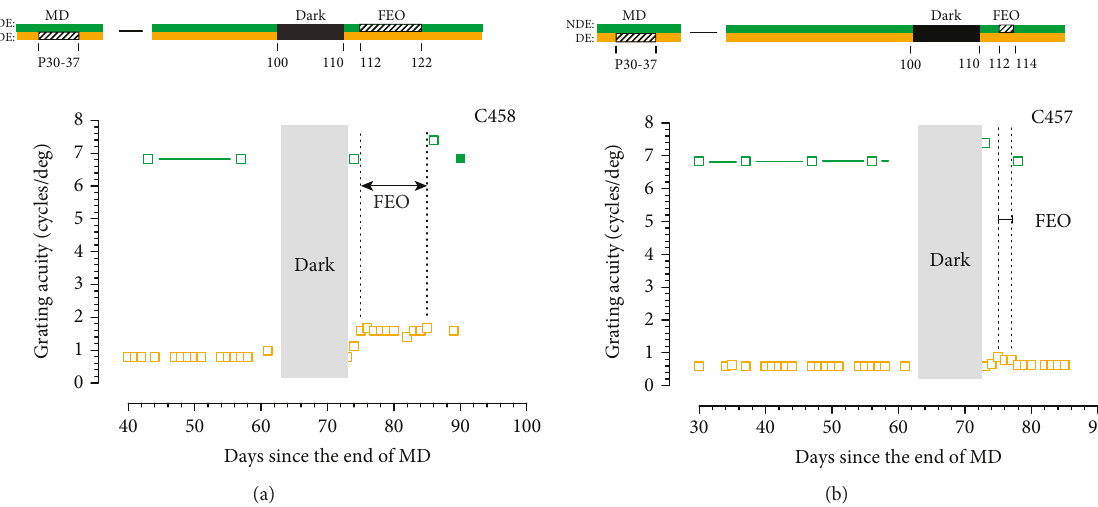
Figure 9: The grating acuity of the deprived eye (orange symbols) and the binocular or nondeprived eye acuity (green symbols) of two monocularly deprived kittens C458 (a) and C457 (b) surrounding 10 days of total darkness followed immediately by a 2-day period of binocular visual exposure that preceded fellow eye occlusion (FEO) for either 10 or 2 days. The period of FEO e ff ectively blocked any further improvement of the acuity of the deprived eye that began during the brief period of binocular visual exposure following the period of